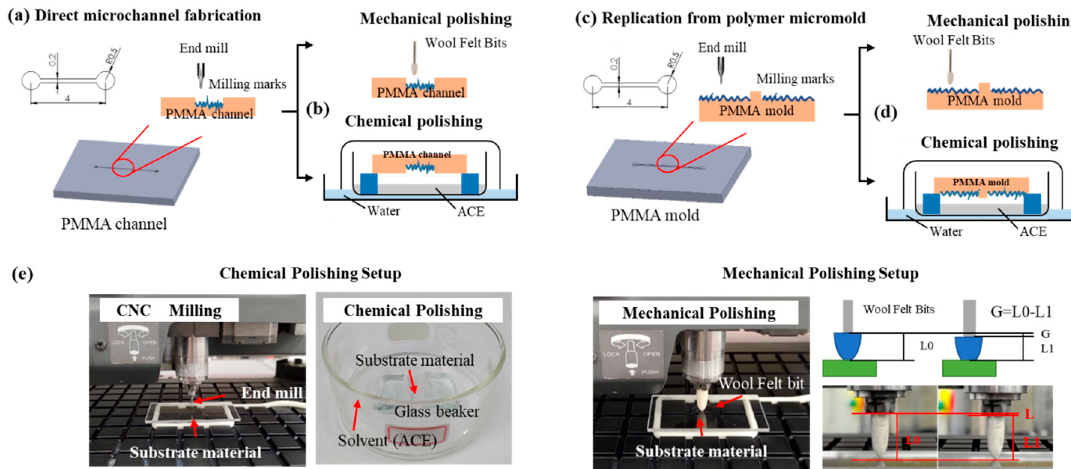
Figure 1. Schematic of ( a ) rapid microchannel prototyping through direct milling for both ( b ) mechanical and chemical polishing. ( c ) shows polymer micromold replication for both ( d ) mechanical and chemical polishing setup. ( e ) displays photographs of the experimental the setup.